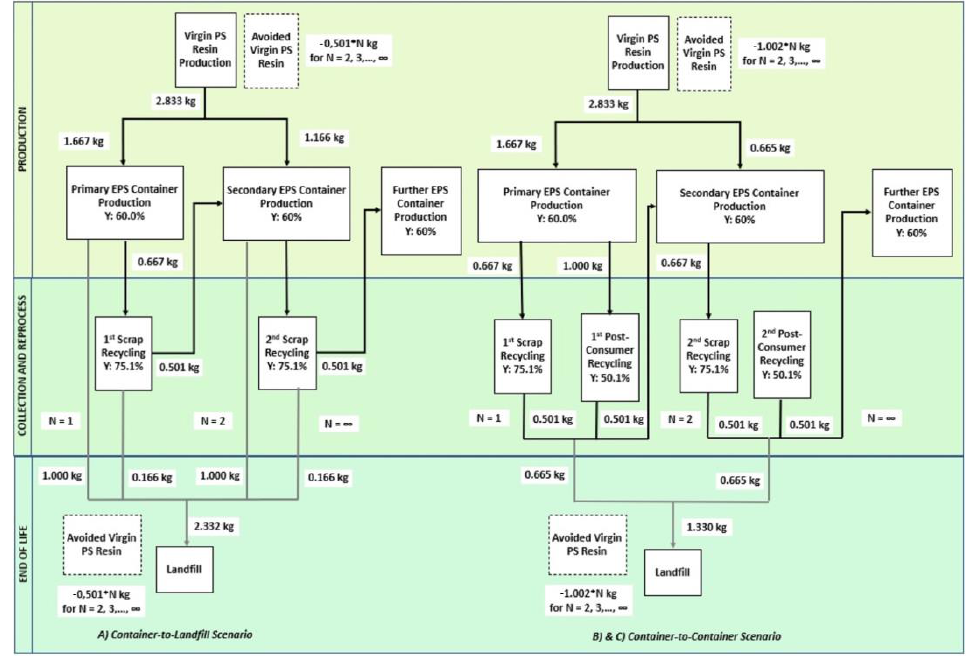
Figure 34. LCA flowchart used to assess the impact of EPS container production. Reprinted with permission from ref. [94].